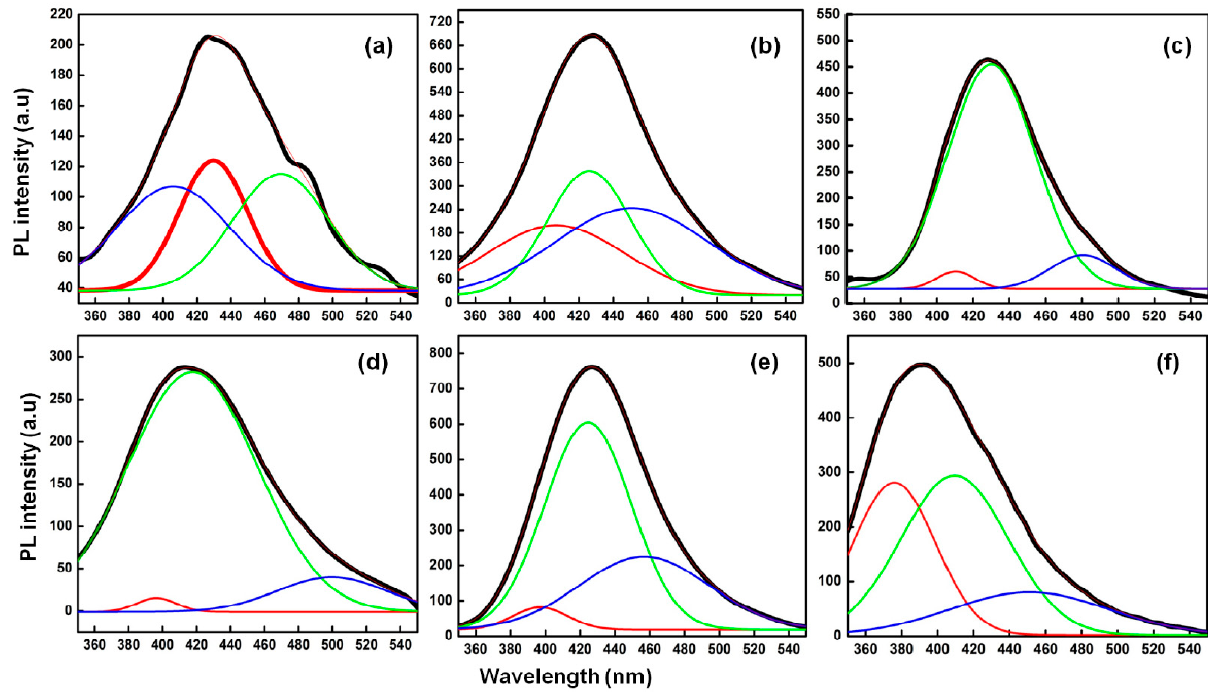
Figure 4. Gaussian analysis of the emission spectra of ( a ) P@C-dots, ( b ) C@C-dots, ( c ) B@C-dots, ( d ) P@ACs, ( e ) C@ACs and ( f ) B@ACs at λ = 310 nm.